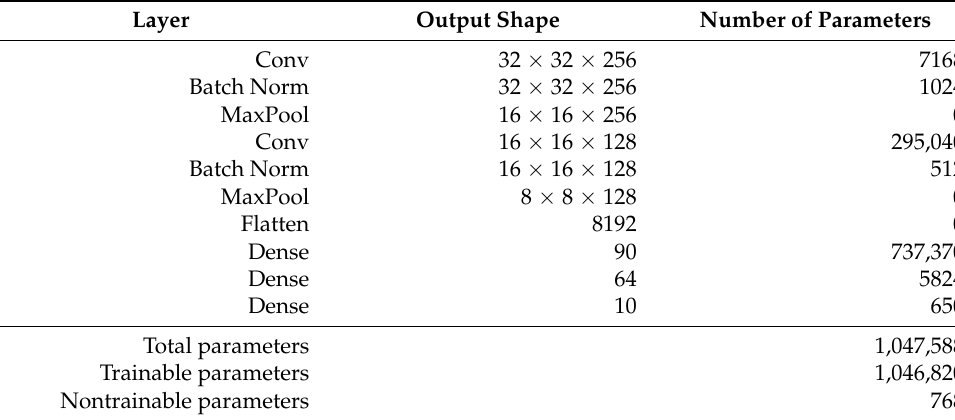
Figure 10. Architecture of CNN for Urdu handwritten numeral recognition. Table 2. Summary of proposed CNN